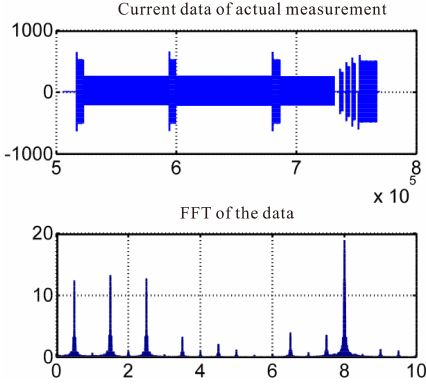
Figure 14. The current data of actual measurement and FFT results.